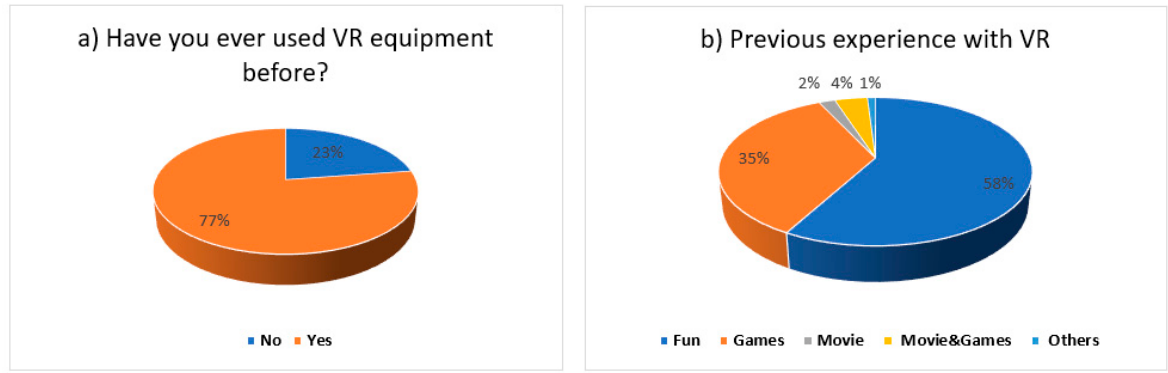
Figure 19. Results of previous experience with VR—( a ) users who had previous experience with VR and ( b ) type of experience with VR equipment.